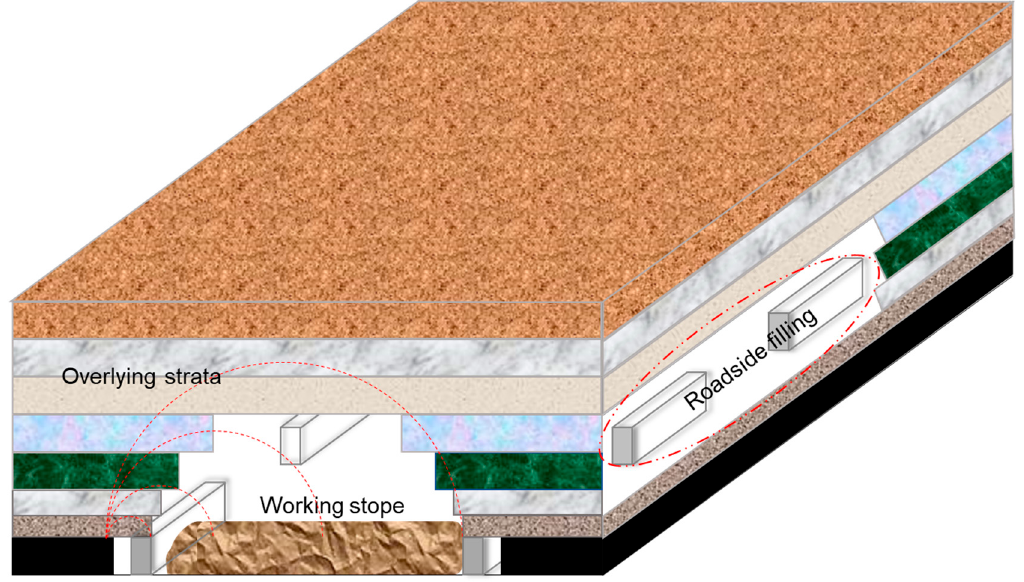
Figure 7. Stope mechanical model of load-bearing structural body.